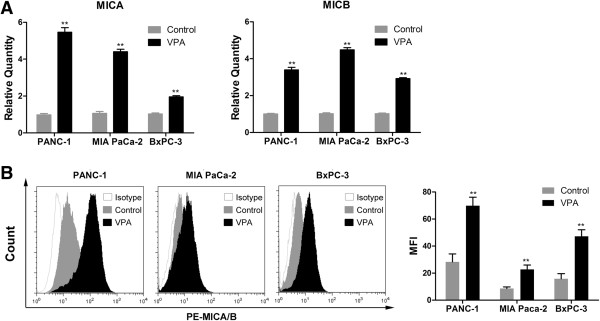
VPA upregulates the expression of MICA and MICB in pancreatic cancer cells. Pancreatic cancer cells were incubated with or without 1 mM VPA for 24 h. (A) Quantitative real-time RT-PCR analysis of MICA and MICB mRNA expression. (B) Flow cytometry analysis and quantification of MICA and MICB protein expression on the surface of pancreatic cancer cells. MFI, mean fluorescence intensity. Data are mean ± SD of a single experiment performed in triplicate, all results were reproducible in three independent experiments. ** P < 0.01.